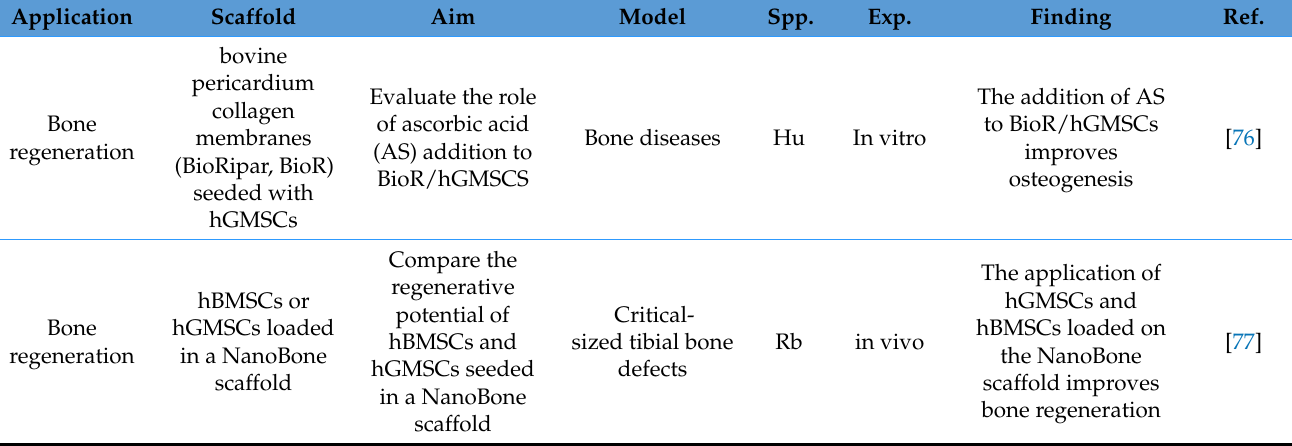
Table 6. hGMSCs application in regenerative